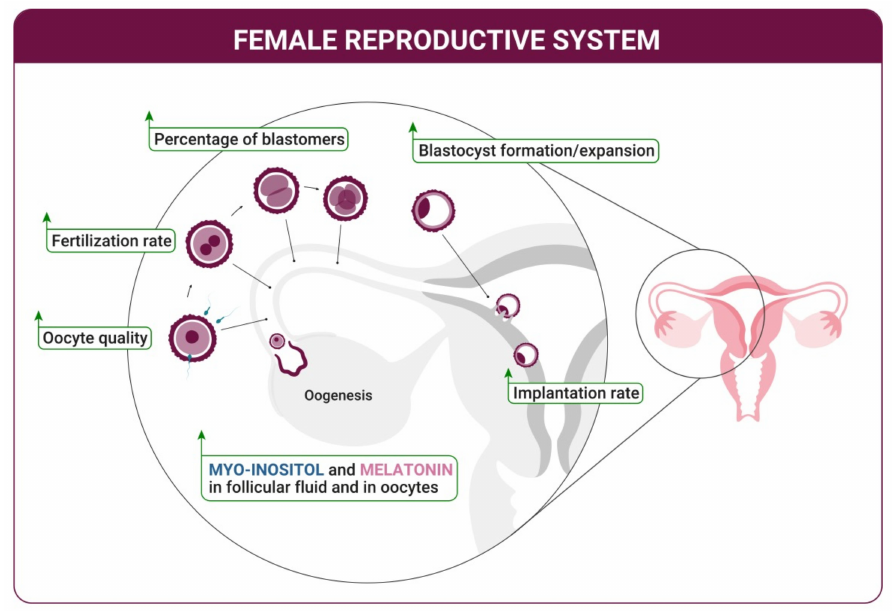
Figure 1. The presence of myo-inositol and melatonin in oocytes and in the follicular fluid positively affects the oogenesis, ameliorates the quality of the oocytes, and promotes the fertilization phase. The result is an increased percentage of blastocyst formation and expansion. Myo-inositol and melatonin sustain the correct attachment of the blastocyst to the uterine endometrium allowing an improvement of the implantation